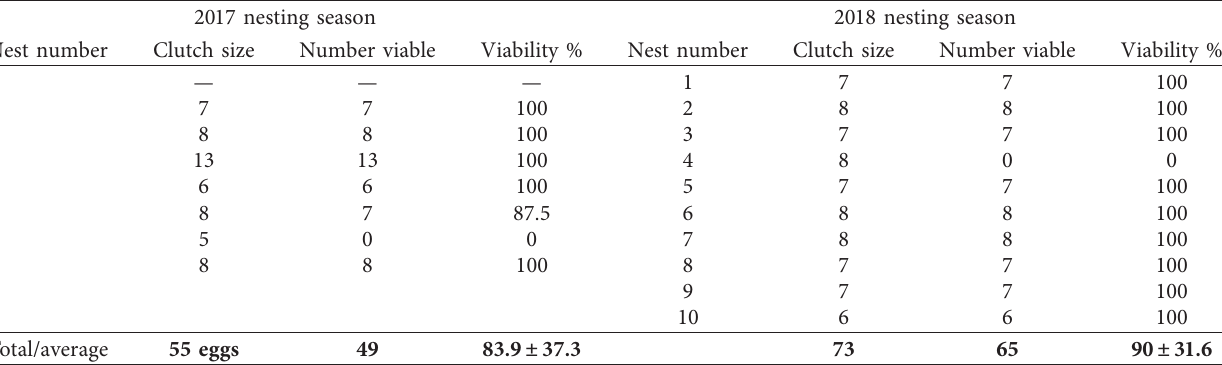
Table 5: The viability of West African dwarf crocodile eggs recorded across two nesting seasons (2017 and 2018) in the Chirehin Community Land, Ghana.